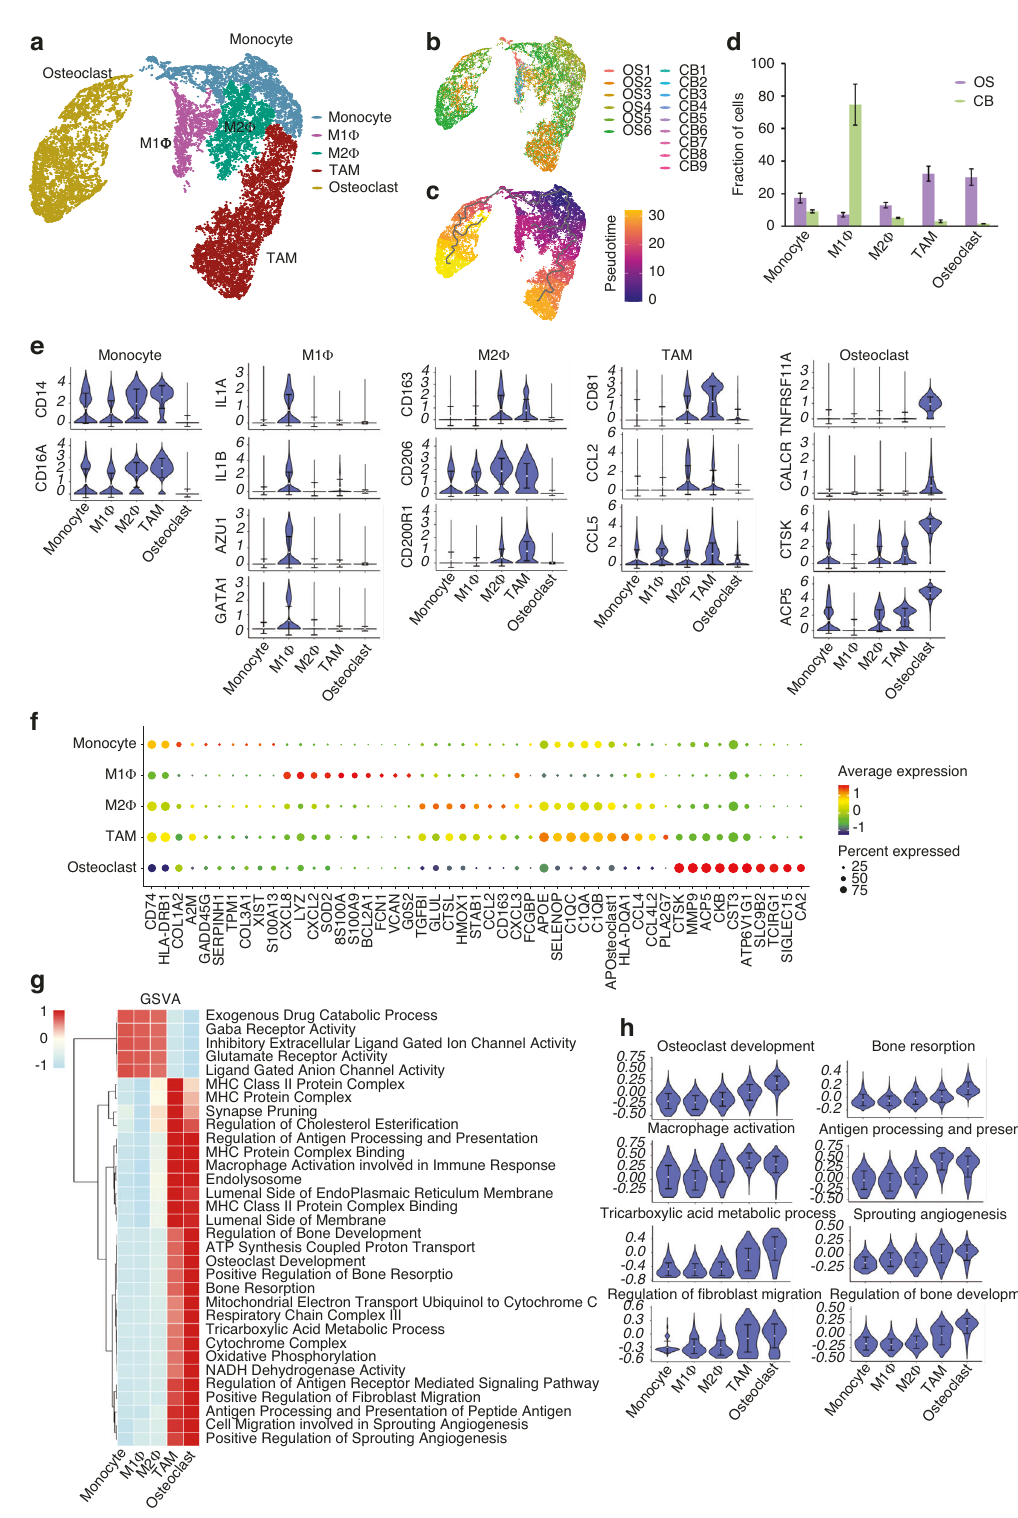
Fig. 7 Activation of tumor-associated macrophages (TAMs) and osteoclasts (OCs) in OS. a UMAP plot of myeloid cells, including OCs, using the Monocle3 method. b UMAP plot of myeloid cells color-coded for each OS and CB sample. c Pseudotime trajectory of myeloid cells. d Differences in cell proportion between OS and CB samples in myeloid cell clusters. e Violin plots showing differences in expression of monocyte, M1 Φ , M2 Φ , TAM, and OC markers in each myeloid cluster. f Dot-plot heatmap of the most signi fi cant genes in the fi ve myeloid clusters. g Heatmap showing differences in pathway activation between the fi ve myeloid clusters calculated by the GSVA method. h Violin plots showing differences in activation of important pathways between the fi ve myeloid clusters, including OC development, bone resorption, macrophage activation involved in immune response, regulation of antigen processing and presentation, tricarboxylic acid metabolic process, positive regulation of sprouting angiogenesis, positive regulation of fi broblast migration, and regulation of bone development pathways (part of the pathway is abbreviated in the fi